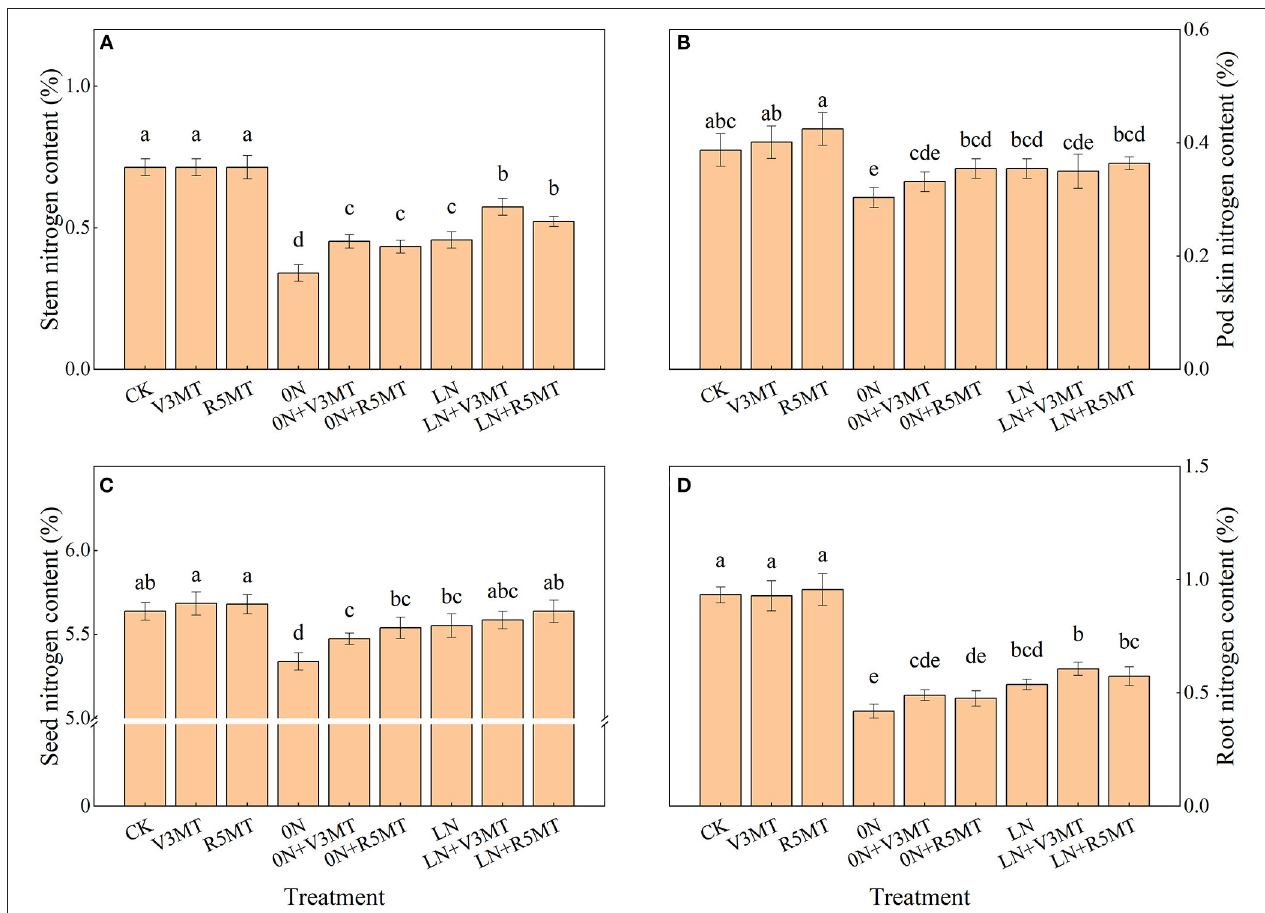
FIGURE 8 | The effect of exogenous melatonin (V3 and R5) on the nitrogen content of stem (A) , pod skin (B) , seed (C) , and root (D) under three N levels. The abbreviated meaning of each treatment is the same as in Figure 3 . The values were presented as mean ± SE ( n = 3). Different letters in one measuring group indicate statistically significant differences when P ≤